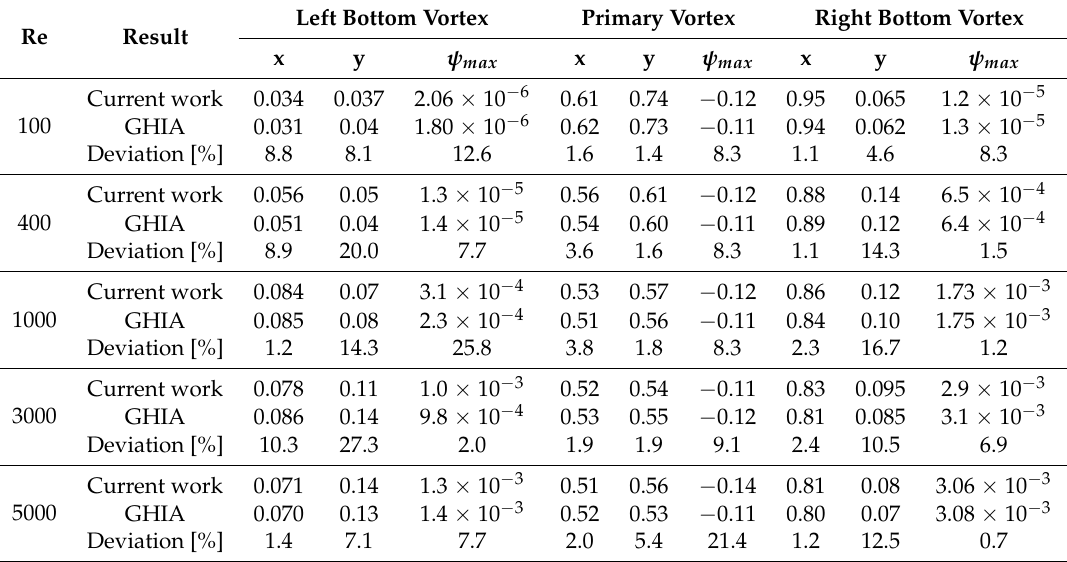
Table 1. Locations of vortices depending on Re and their comparison with the results of Ghia et al. [2]